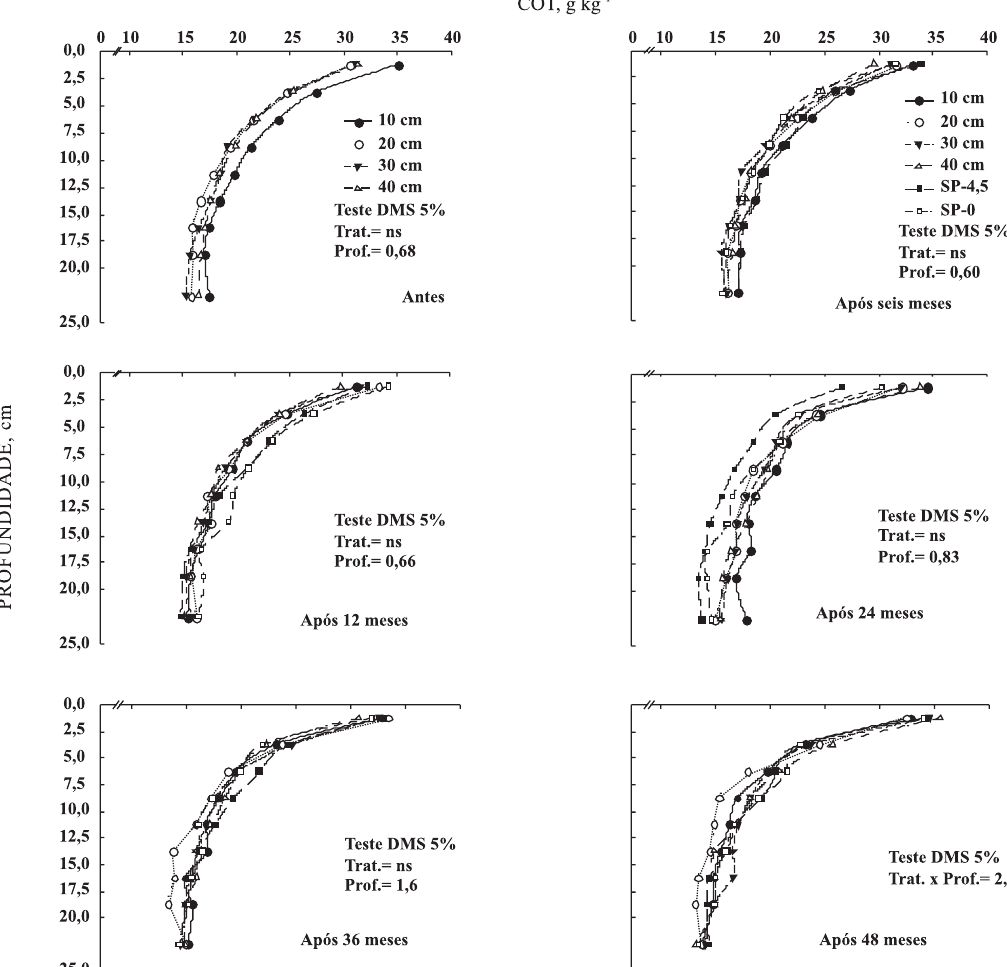
Figura 7. Teores de carbono orgânico total (COT) em diferentes épocas da aplicação superficial de calcário em Latossolo Vermelho, sob sistema plantio direto e integração lavoura-pecuária, com diferentes pressões de pastejo no inverno (ns: não